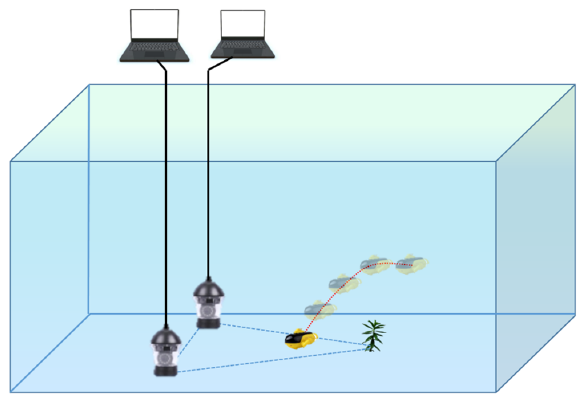
Figure 4. UVNets: an underwater vision target detection and tracking system.